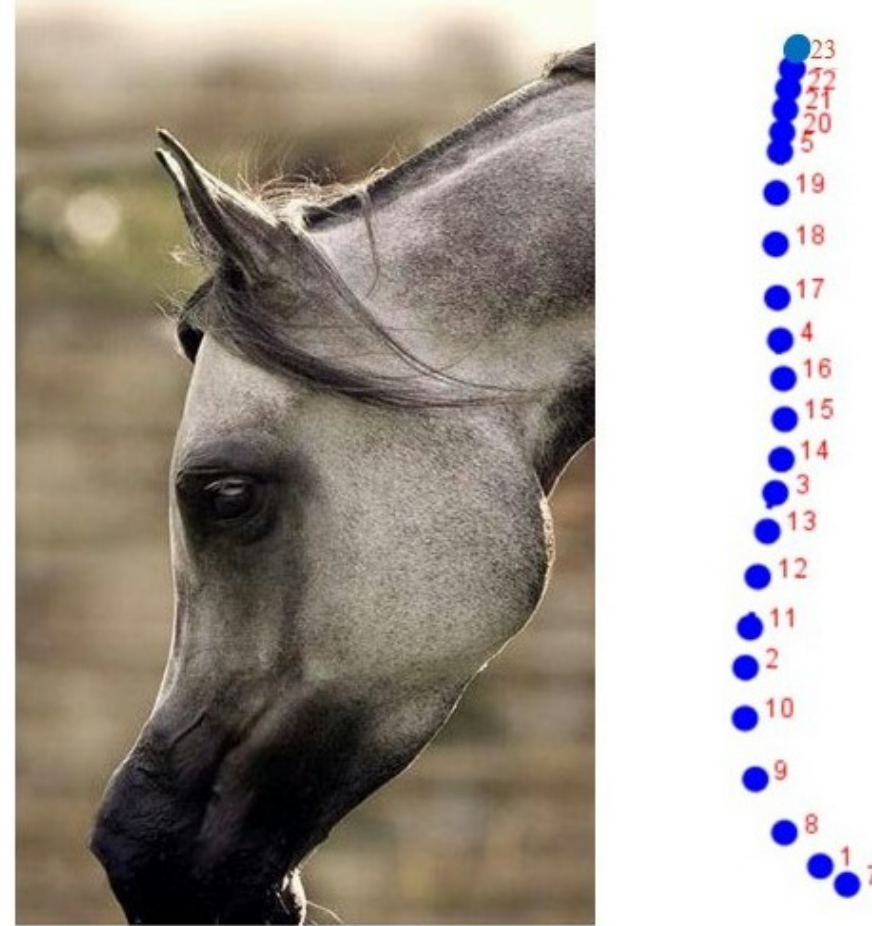
Figure 1. Left : Left lateral profile of the head. Right : Set of 23 semi-landmarks used initially to define the cephalic profile in the Purebred Arabian Horse. A sub-set of 14 semi-landmarks, which defined both the frontal and facial profile, was finally chosen (Table 1). Table 1. Results for Principal Component Analysis. The first two Principal Components (PC) ac- counted for 80.65% of the total variance observed (PC1 + PC2 = 66.60% + 14.05%). The 14 anatomical semi-landmarks with the highest discriminative value (>[0.2]) appear in bold. PC1 (66.60%)